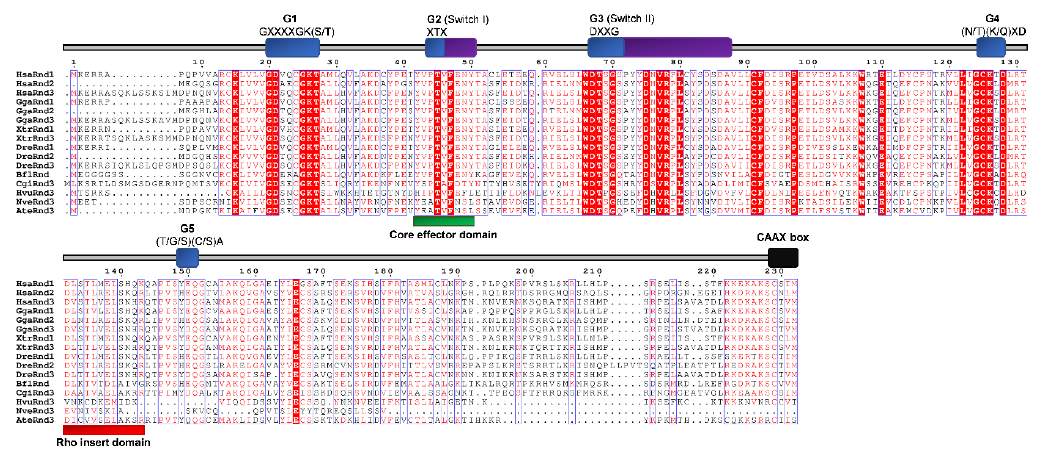
Figure 8. Sequence alignment of the Rnd subfamily. The amino acid sequences of Rnd GTPases were aligned using ClustalX, the secondary structures predicted using ESPript. Regions of the Rnd proteins are indicated above the alignment; blue are the G domains, (G1, G2, G3, G4, and G5 with their respected motifs), purple are switch 1 and switch 2 domains, red is the Rho insert, green is the core effector domain, and black is the CAAX box. Blue frames are indicators of the conserved residues; white letters in red boxes represent identity, and red letters in white boxes represent similarity.